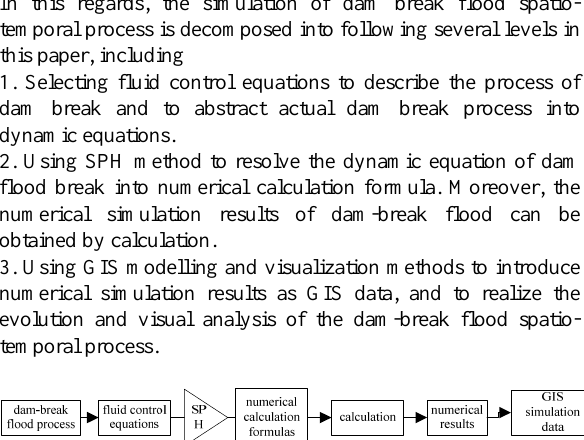
Fig.1 The flow of simulation method for dam-break flood spatio-temporal